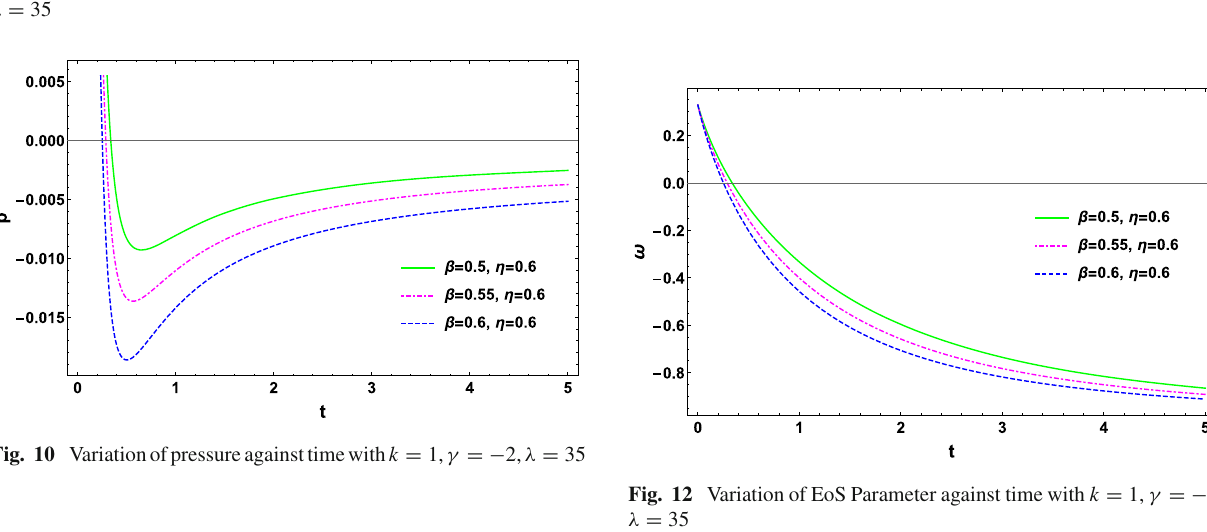
Fig. 11 Variation of pressure against z with k = 1, γ = − 2, λ = 35